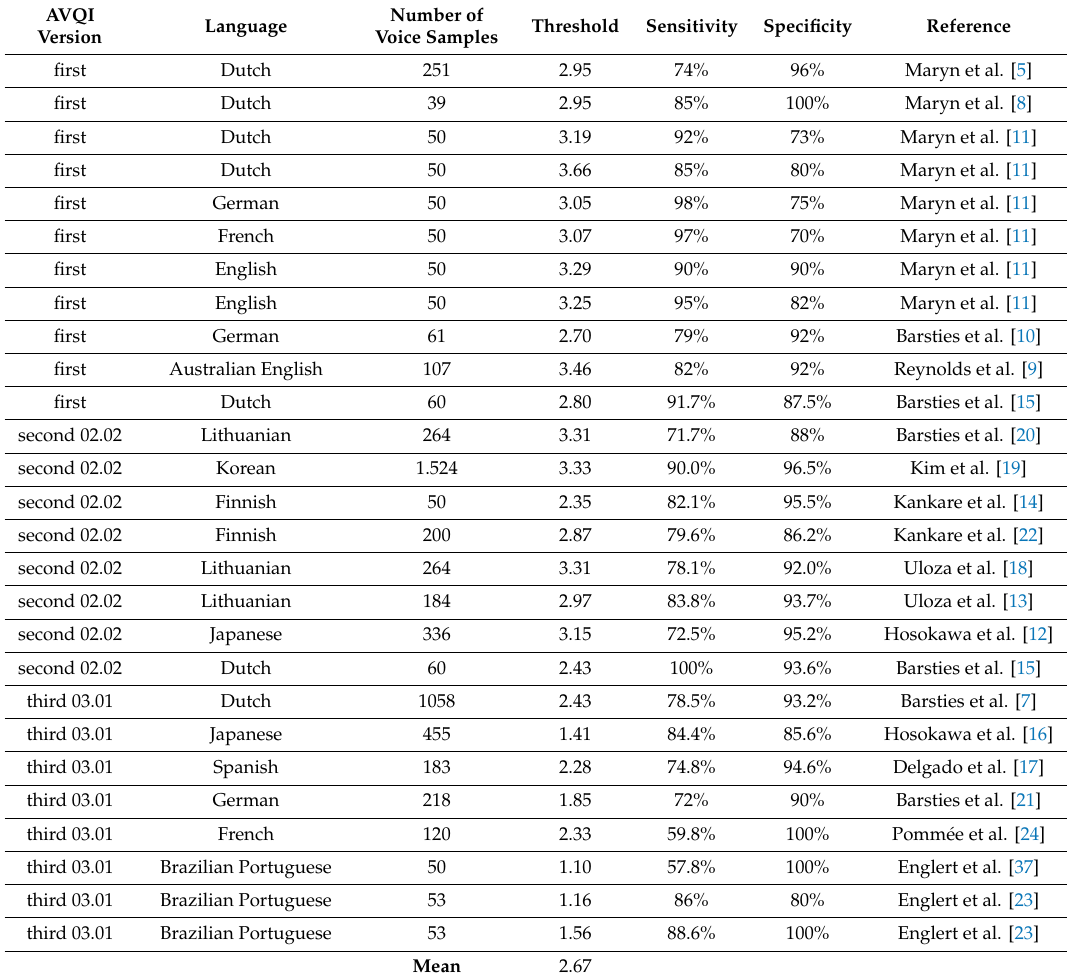
Table 1. List of acoustic voice quality index (AVQI) thresholds in previous studies, investigating AVQI in di ff erent languages, with the version of AVQI used, the language, the number of evaluated voice samples, and sensitivity and specificity level and